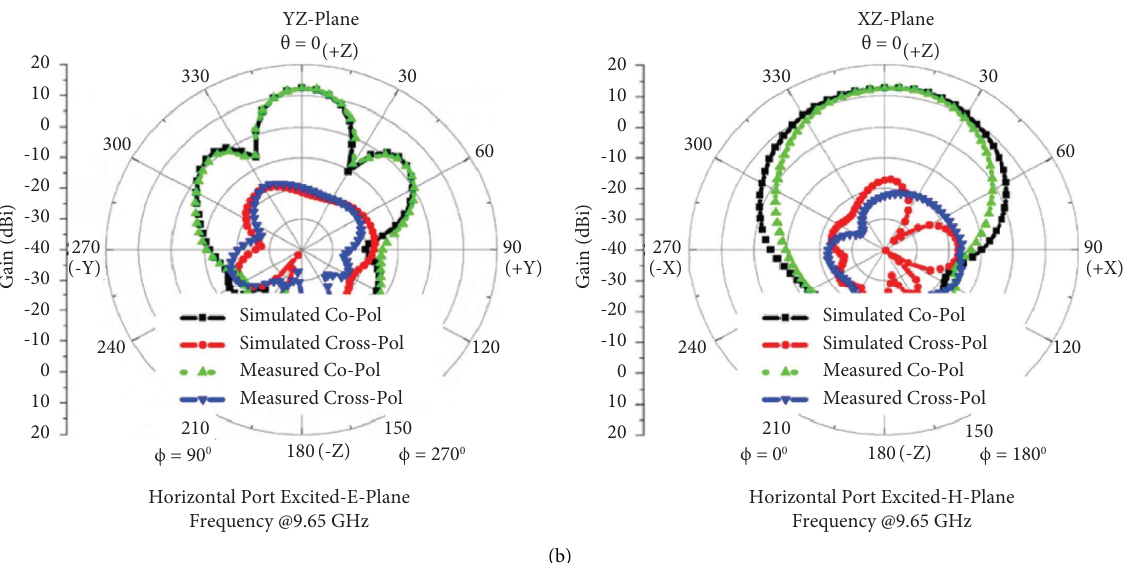
Figure 14: (a) Simulated and measured radiation pattern of port-4 excited phi � 90 ° -plane @9.65GHz. and port-4 excited phi � 0 ° -plane @9.65GHz. (b) Simulated and measured radiation pattern of port-6 excited phi � 90 ° -plane @9.65GHz and port-6 excited phi � 0 ° -plane @9.65GHz.